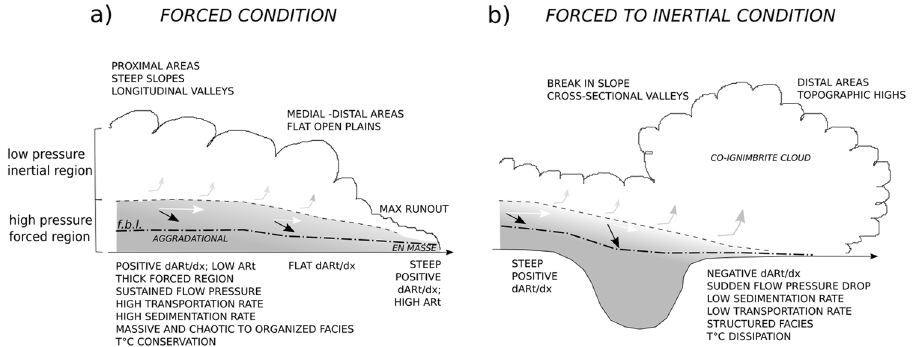
Figure 4. Model explaining AR t gradients of ignimbrites in terms of degree of forcing or inertia of the parent PDCs (see text for explanation). White arrow = sediment transport; black arrow = sediment deposition; their dimensions indicate the relative magnitudes. The ignimbrite lithofacies results from the control of the sediment flux over the position of the flow boundary layer (f.b.l.) respect to the top of the forced